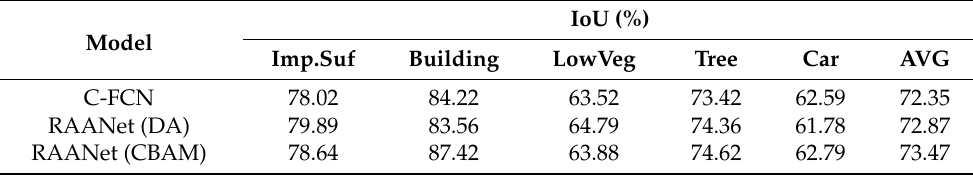
Table 8. Quantitative comparison of IoU (%) with C-FCN on ISPRS Vaihingen challenge test set.